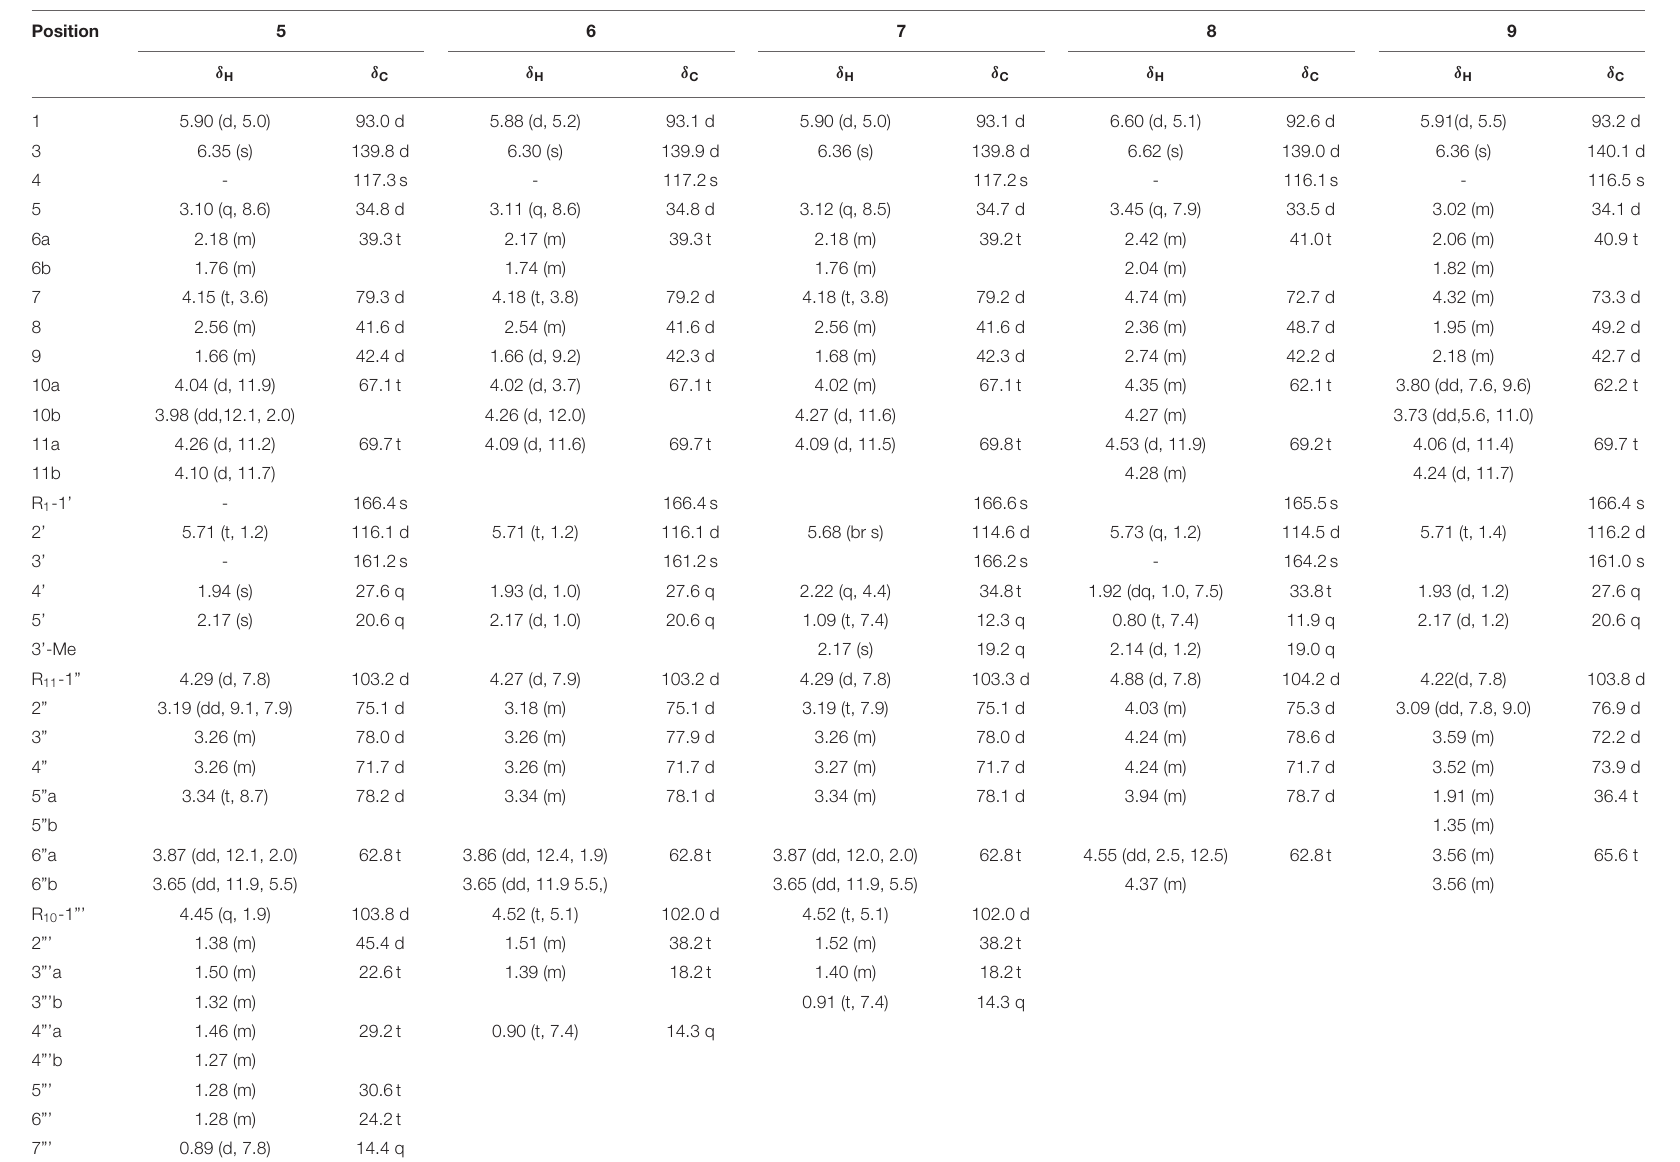
TABLE 2 | The 1 H and 13 C NMR data of 5-9 (CD 3 OD, δ in ppm, J in Hz).